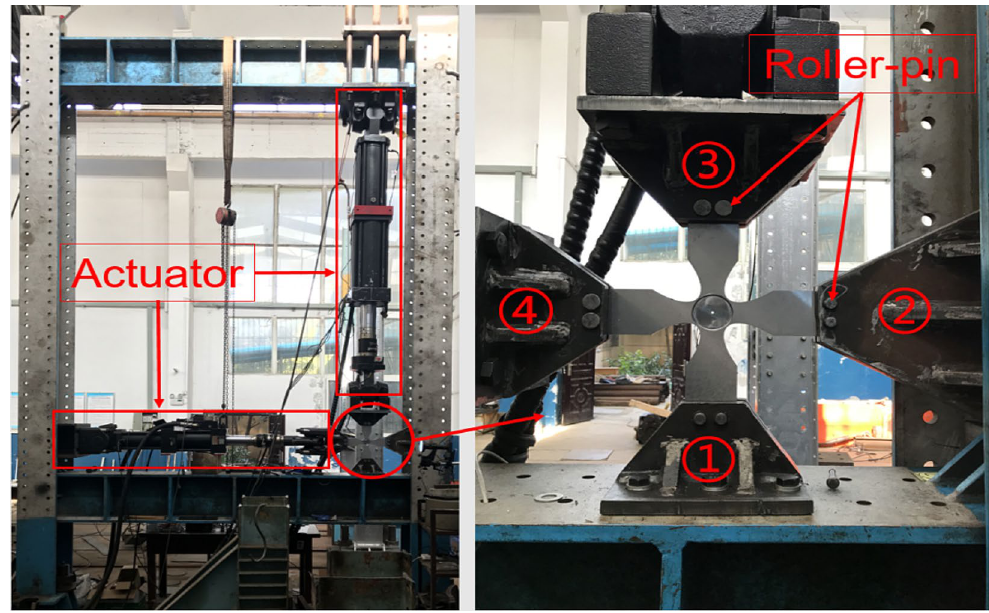
Fig. 2 Experimental assembly and local